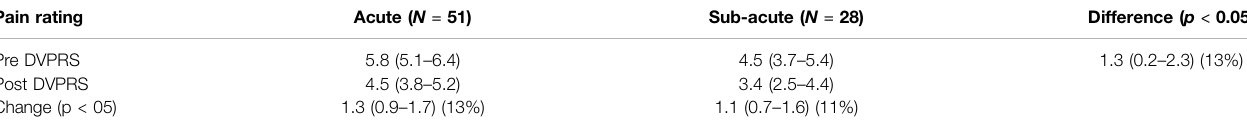
TABLE 4 | Pain rating (DVPRS 0 – 10) by level of care. Pain